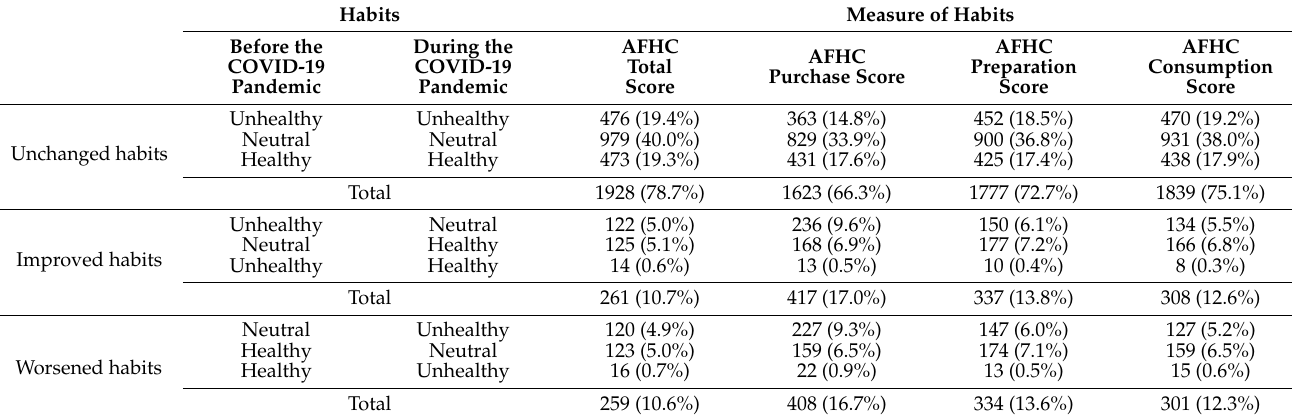
Table 6. The changes of dietary habits scores for purchase, preparation, consumption and total habits in categories of healthy, neutral and unhealthy habits calculated on the basis of the Adolescents’ Food Habits Checklist (AFHC) within the PLACE-19